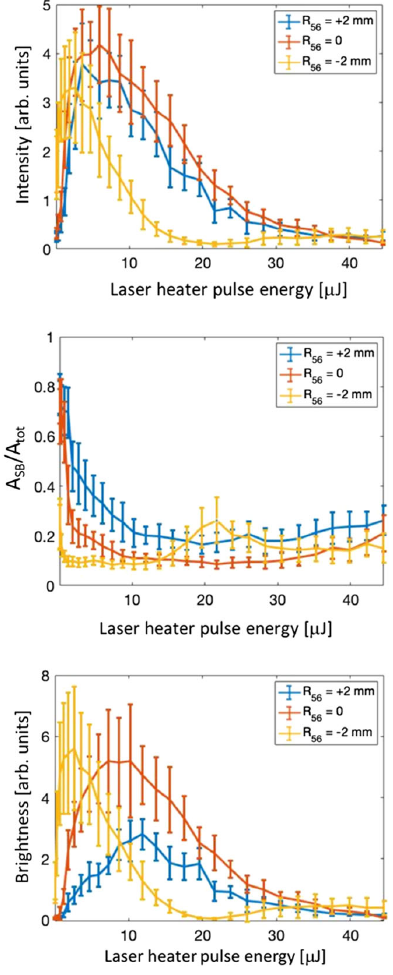
FIG. 3. EEHG signal recorded at 7.3 nm, for the three spreader optics in Fig. 1, as a function of the laser heater pulse energy. From top to bottom: Total signal; ratio of the pedestal signal over the total FEL signal; total signal over FWHM bandwidth. All quantities are in arbitrary